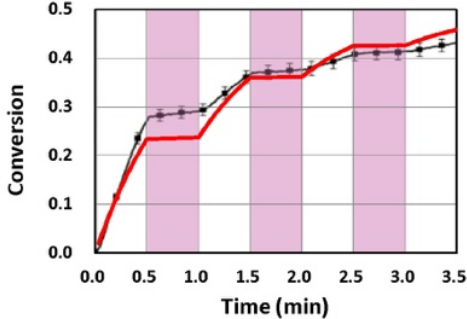
Figure 9. Methacrylate conversion of a bisGMA/TEGDMA resin formulated with 0.2 wt% CQ/0.5 wt% EDAB/0/5 wt% BN and subject to a continuous exposure of a blue light, but an on-off exposure of a UV-light for 0.5 min, as indicated by the violet vertical areas; where black bars are measured data from van der Laan et al. [11] and red curve is our theoretical simulation.